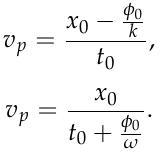
Figure 1. Wavepacket arriving at 𝑥 0 at time 𝑡 0 with phase 𝜙 0 propagating at group velocity 𝑣 𝑔 . 𝐺(𝑡) is represented as the envelope of the wavepacket.